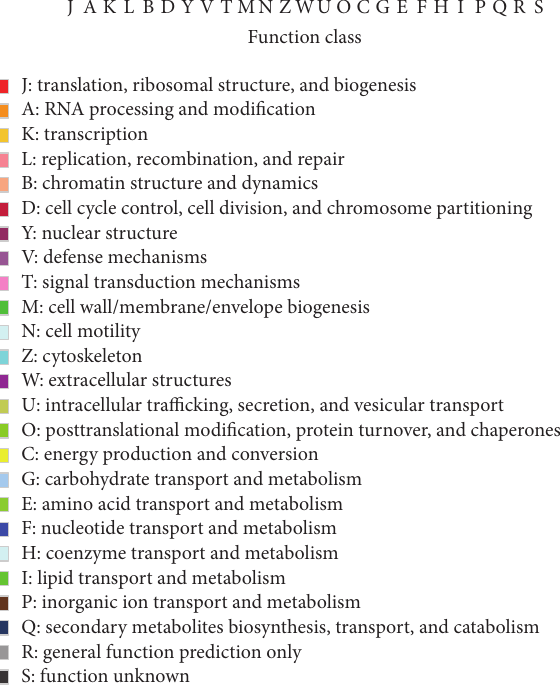
Figure 3: COG function classification of all